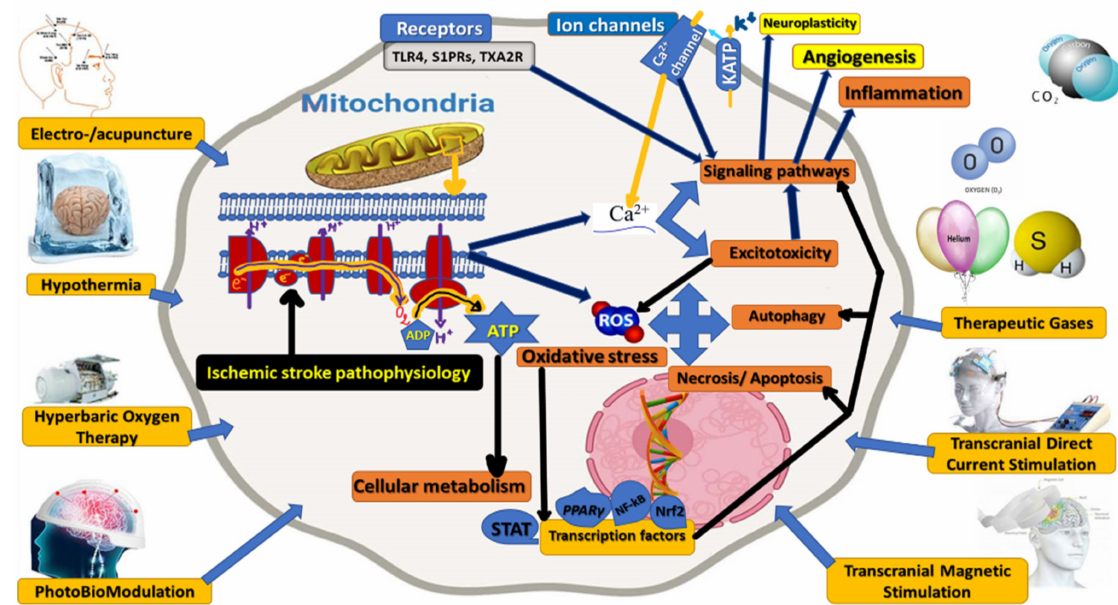
Figure 3. Cellular and molecular mechanisms as presumptive therapeutic/rehabilitative targets in acute ischemic stroke for non-invasive, non-pharmacological therapeutic/rehabilitative interven- tions: electro-/acupuncture, hyperbaric oxygen therapy, hypothermia/cooling, photobiomodulation, therapeutic gases, transcranial direct currents stimulations, or transcranial magnetic